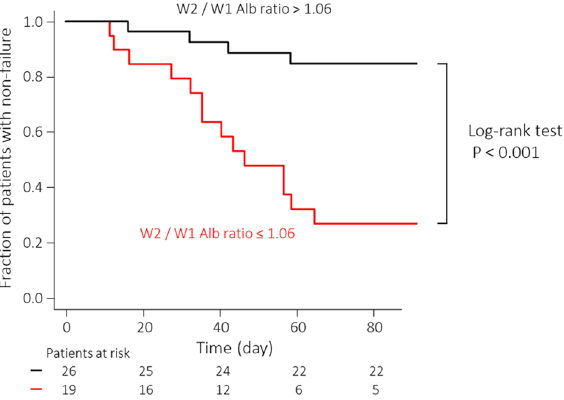
Figure 1. Kaplan–Meier time-to-relapse curve of patients with ulcerative colitis (UC) in relation to the week 2 (W2)/week 1 (W1) albumin (Alb) ratios > 1.06 and ≤ 1.06.